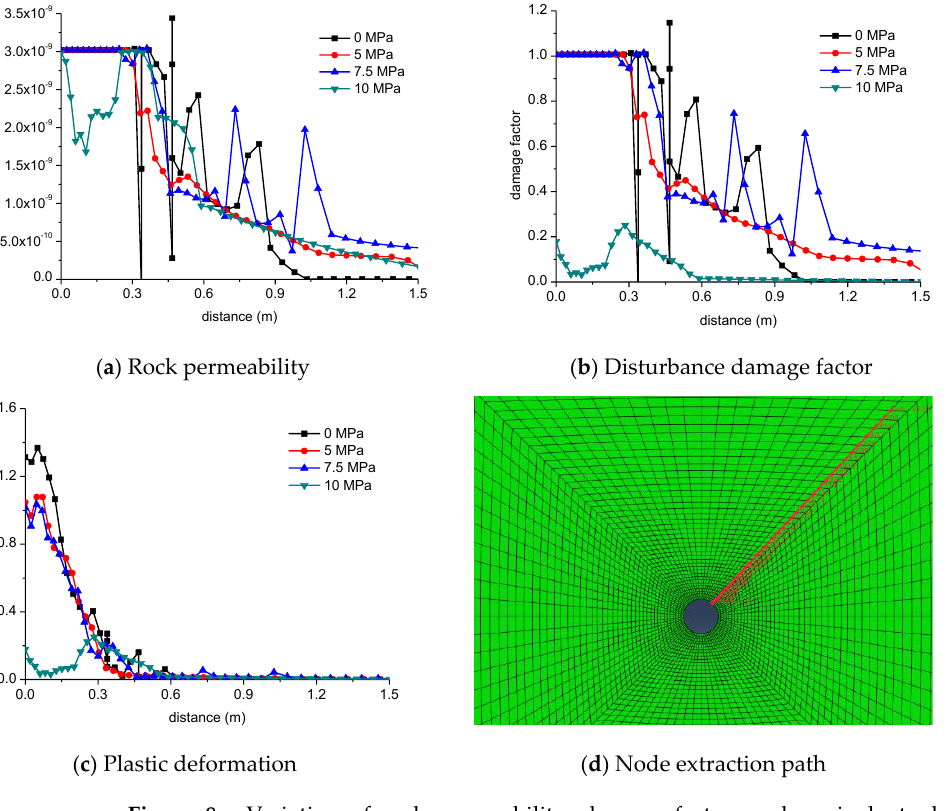
Figure 8. Variation of rock permeability, damage factor, and equivalent plastic strain with different distance.